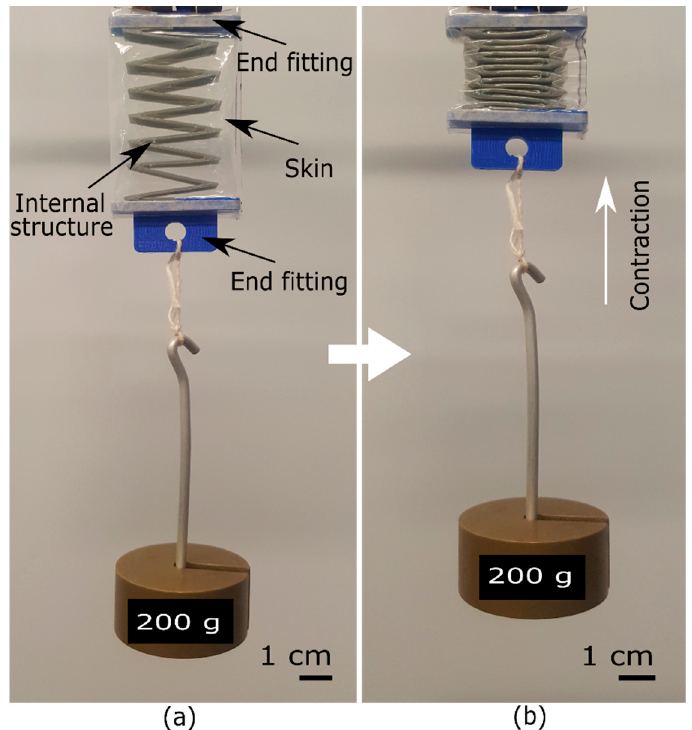
Figure 1. Our low ‐ profile vacuum powered artificial muscle LP ‐ VPAM with a load of 0.2 kg directly